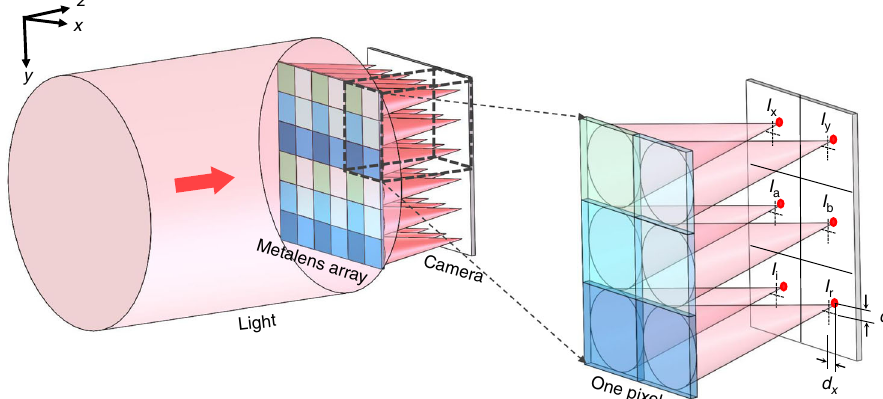
Fig. 1 Scheme of the generalized Hartmann – Shack beam pro fi ler. To measure not only phase gradients but also allow for complete polarimetric beam pro fi ling, each pixel of the array shown on the left consists of six different polarization-sensitive metalenses. A camera records a magni fi cation of the common plane of the metalens foci (magni fi cation not depicted, see Supplementary Figs. 4 and 6). The dotted crosses on the camera plane in the right panel show the projections of the corresponding metalens